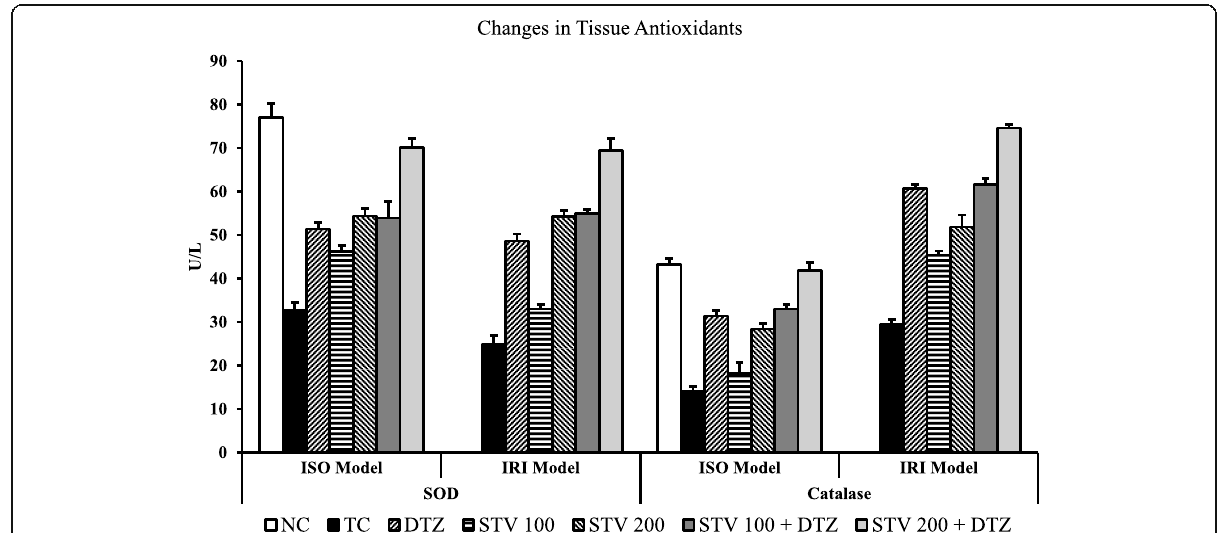
Fig. 4 Effect of STV, DTZ, and their combination on tissue antioxidant levels